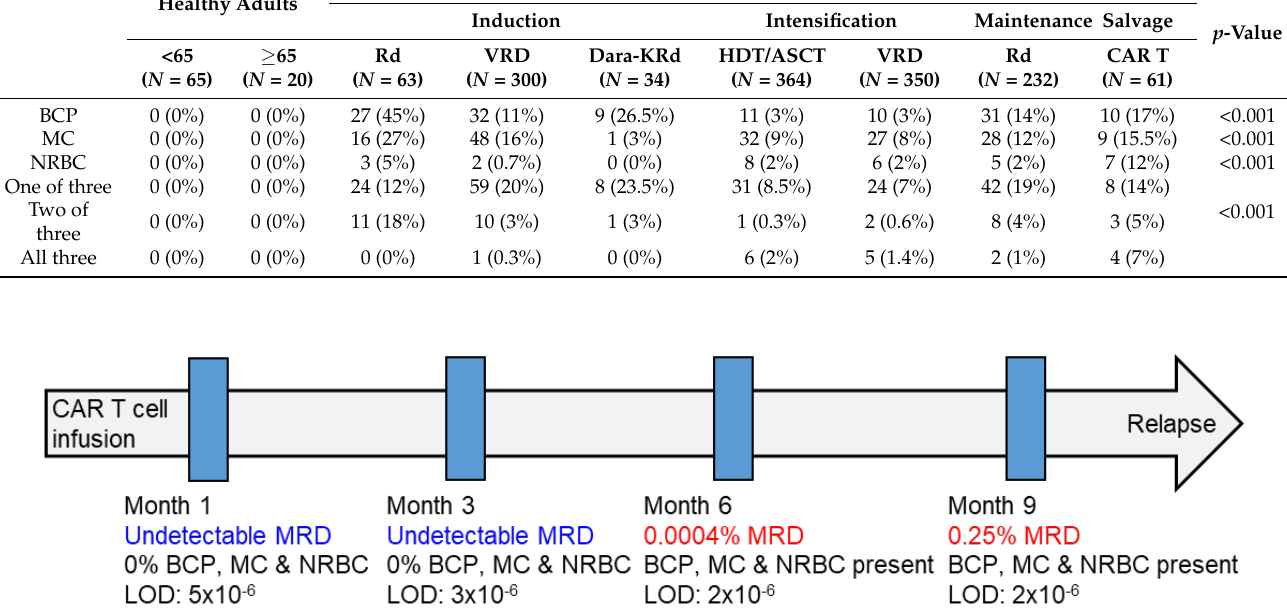
Table 3. Frequency of bone marrow aspirates with undetectable B-cell precursors, mast cells and nucleated red blood cells (NRBC). Data is shown per cell type, as well as the absence of any of the three, two or all three cell types. Healthy adults (HA) were grouped according to age (younger and older than 65), whereas patients with multiple myeloma were grouped according to treatment: induction with lenalidomide and low-dose dexamethasone (Rd) with or without clarithromycin, bortezomib, lenalidomide and dexamethasone (VRD), daratumumab, carfilzomib, lenalidomide and dexamethasone (Dara-KRd); intensification with high-dose chemotherapy followed by autologous stem cell transplantation (HDT/ASCT) and consolidation with VRD; maintenance therapy with Rd plus/minus ixazomib and salvage therapy with anti-BCMA CAR T cells.